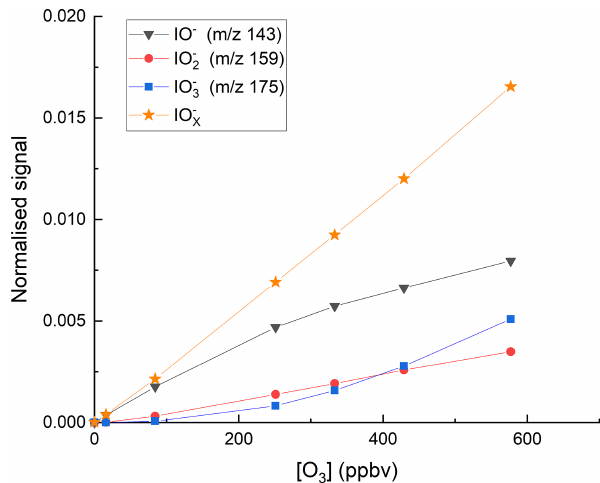
Figure 3. Variation of the I-CIMS signals at m/z 143 (IO − ), 159 (IO 2 − ) and 175 (IO 3 − ) with the mixing ratios of O 3 . The O 3 mix- ing ratios are those measured in air before the gas flow entered the inlet. The water vapour was held constant using our standard setting ( [ H 2 O ] IMR = 2 . 9 × 10 14 moleculecm − 3